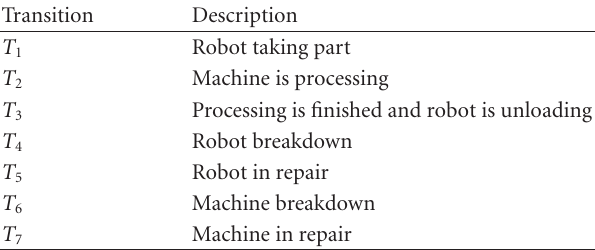
Table 10: Description of transitions in Figure